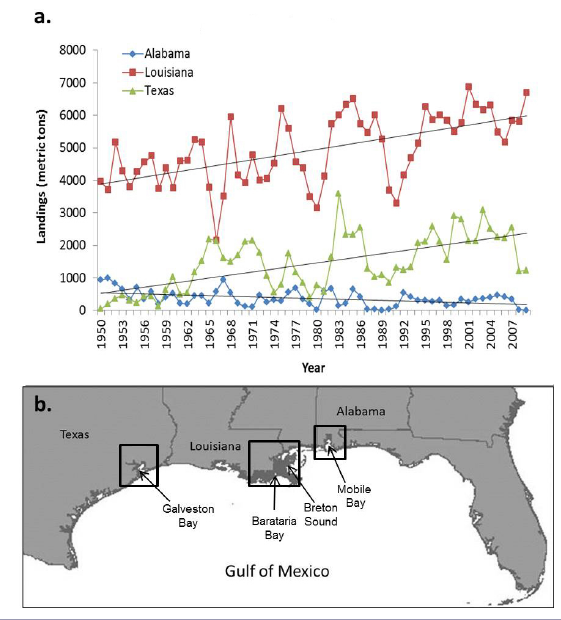
Fig. 2 . Historical harvest of oysters ( Crassostrea virginica ) in Alabama, Louisiana, and Texas according to the National Marine Fisheries Service landings database (a), and map of the northern Gulf of Mexico with black squares surrounding the study regions